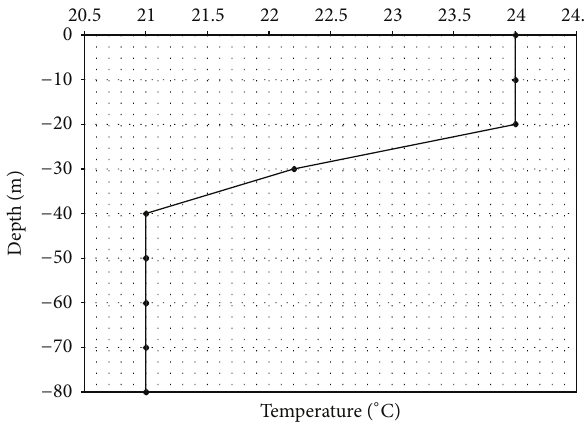
Figure 3: Initial vertical temperature profile for Lake